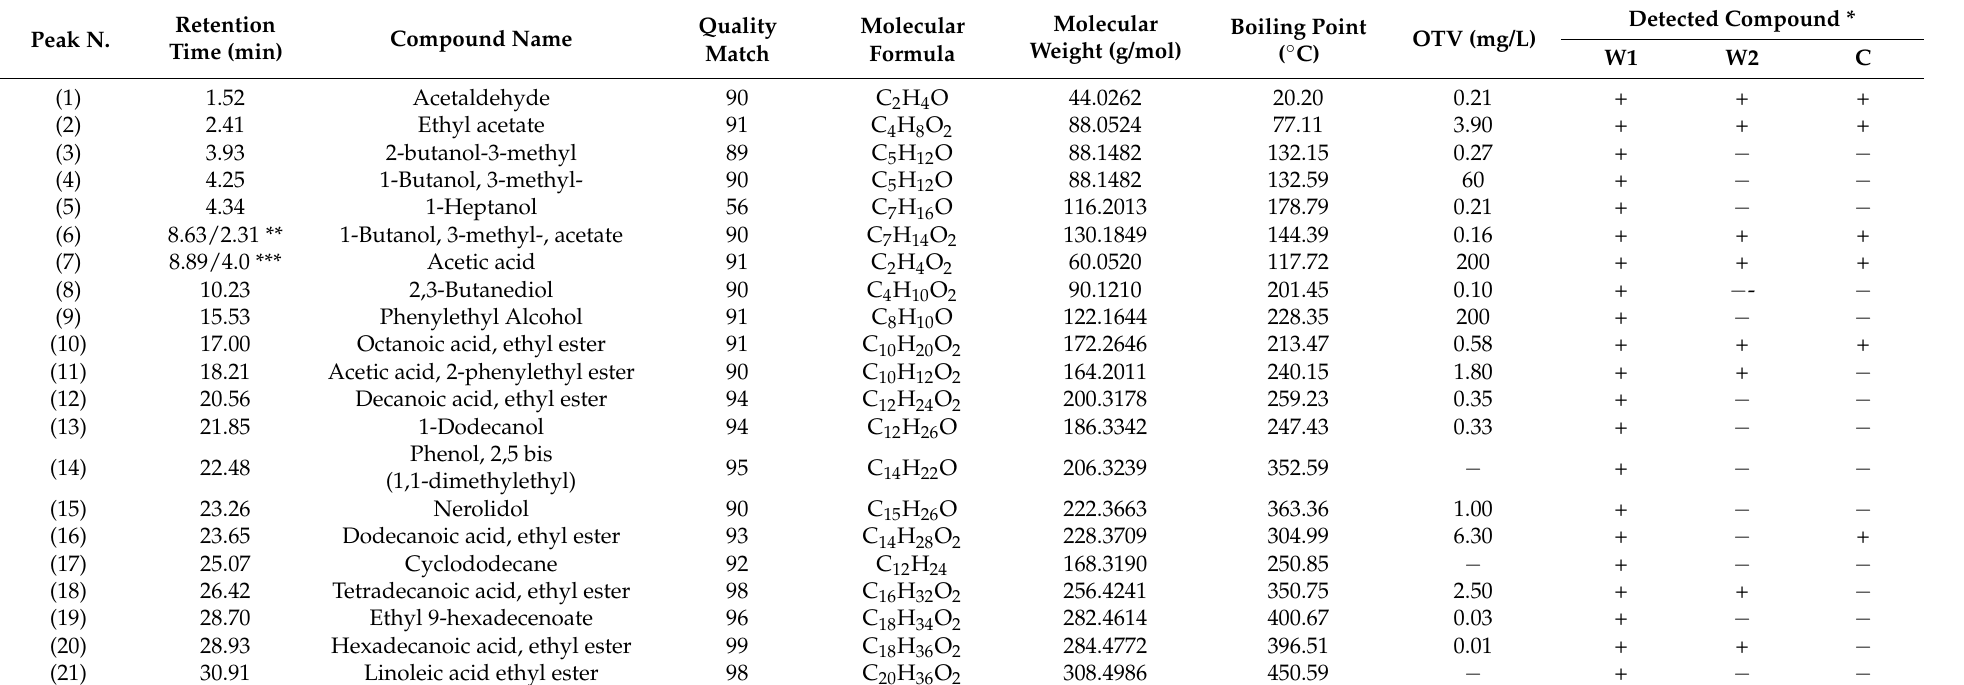
Table 3. Retention times, quality match values with the NIST library data, molecular formula, molecular weight, boiling points, odour threshold values (OTVs) of the organic volatile compounds identified in the Aglianico wine sample obtained by fermentation with the mixed starters S. cerevisiae and H. osmophila and in the control, i.e., Aglianico wine sample obtained by fermentation with S. cerevisiae alone. Peak